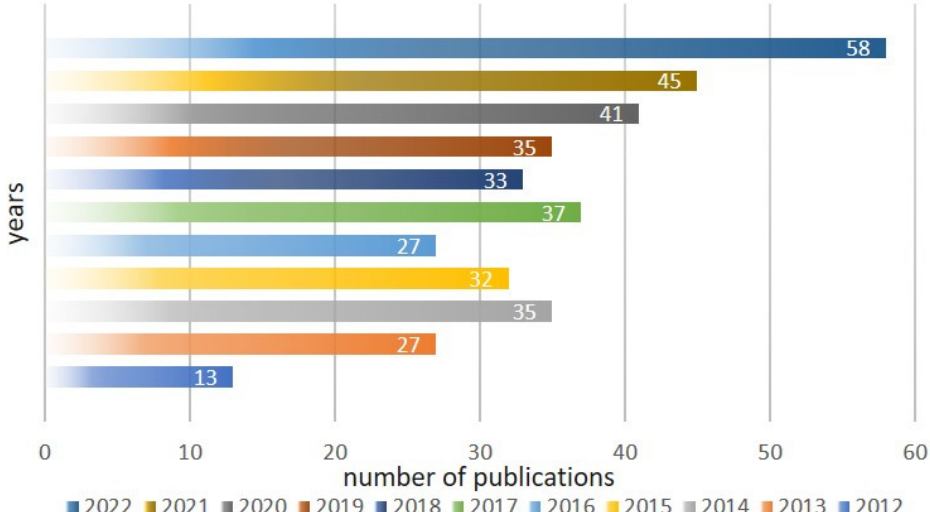
Figure 2. The progress of recent investigations into layered perovskites as prospective materials for solid oxide fuel cells.